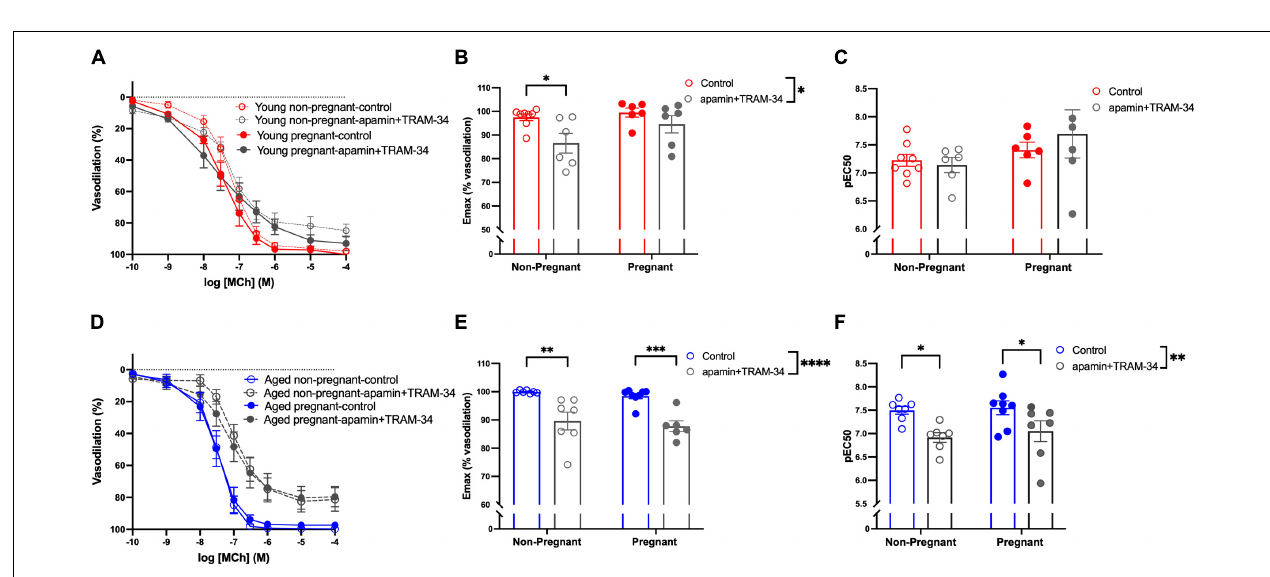
FIGURE 5 | Increased endothelium-derived hyperpolarization-mediated relaxation in mesenteric arteries from aged non-pregnant and pregnant rats. (A,D) Endothelium-dependent vasodilation responses to increasing doses of methylcholine (MCh) in the presence or absence of apamin/TRAM-34 in mesenteric arteries of young [3–4 months; in red; (A–C) ] and aged [9–9.5 months; in blue; (D–F) ] pregnant (on gestational day 20; closed circles) and non-pregnant (age-matched; open circles) rats. (B,E) Data summaries of the maximal vasodilation responses to MCh (E max ). (C,F) Data summaries of the sensitivity to MCh (pEC 50 ). Data are presented as mean ± SEM; analyzed by two-way ANOVA with Sidak’s multiple comparisons post hoc test; ∗ p < 0.05, ∗∗ p < 0.01, ∗∗∗ p < 0.001, ∗∗∗∗ p < 0.0001; n = 6–8/group.